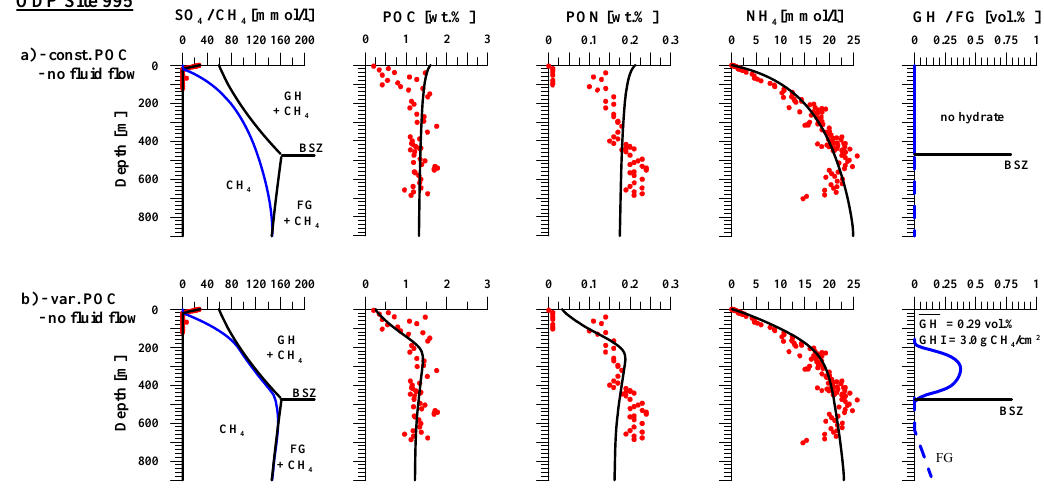
Fig. 6. Model results for ODP Site 995 at Blake Ridge for two different model runs: (a) constant POC input, and (b) time varying POC input.